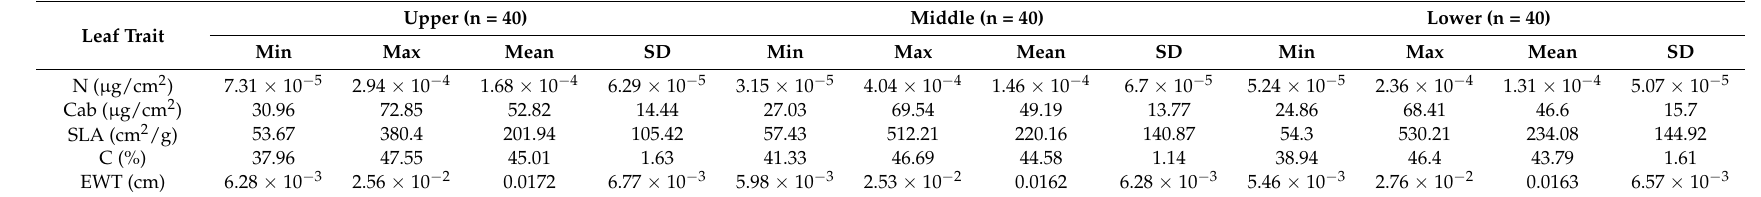
Table 1. Summary statistics of leaf traits at the three canopy